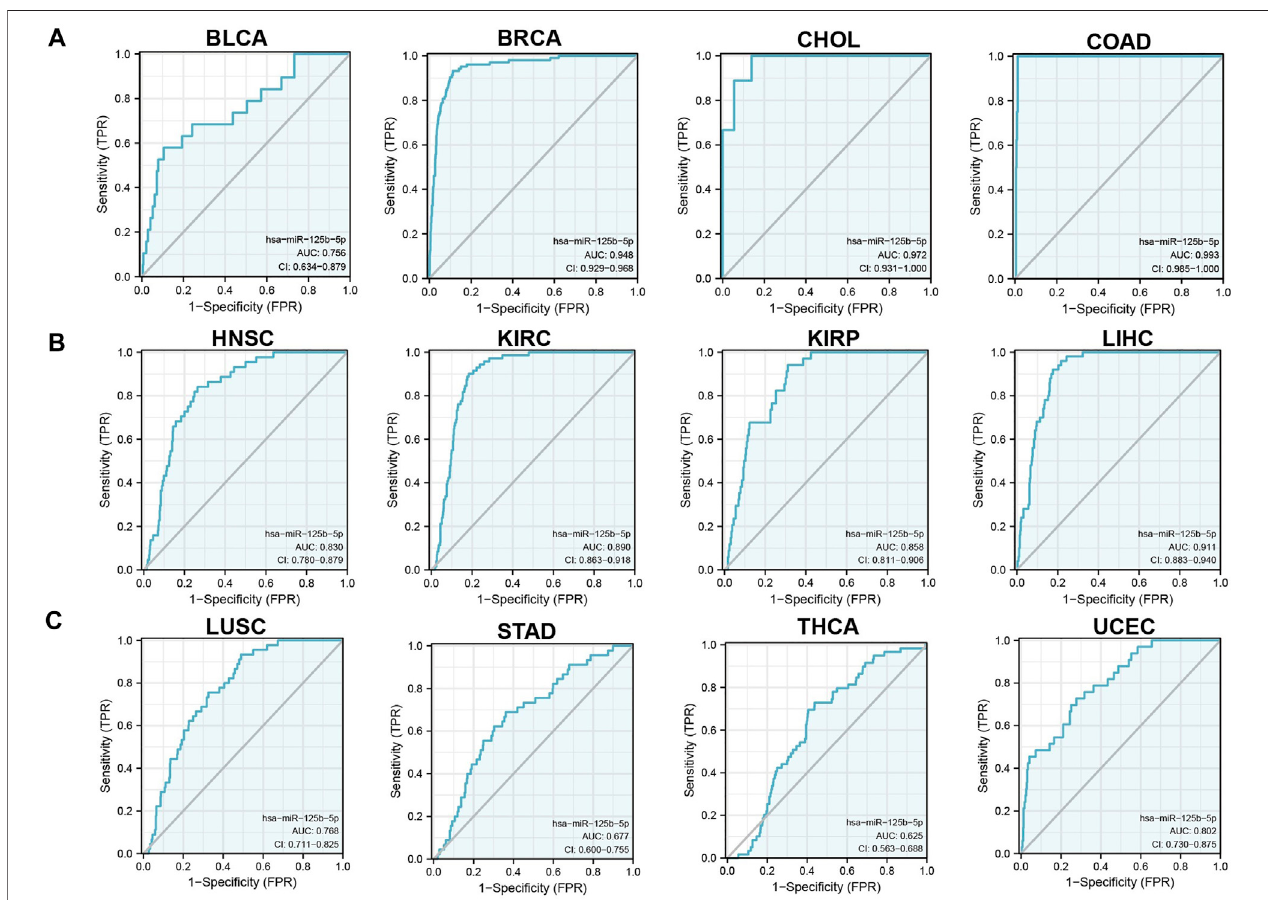
FIGURE 2 | Analysis of the receiver operating characteristic (ROC) curve for miR-125b-5p in human cancers. (A – C) ROC curve analysis and area under the curve (AUC) values for miR-125b-5p in diverse human